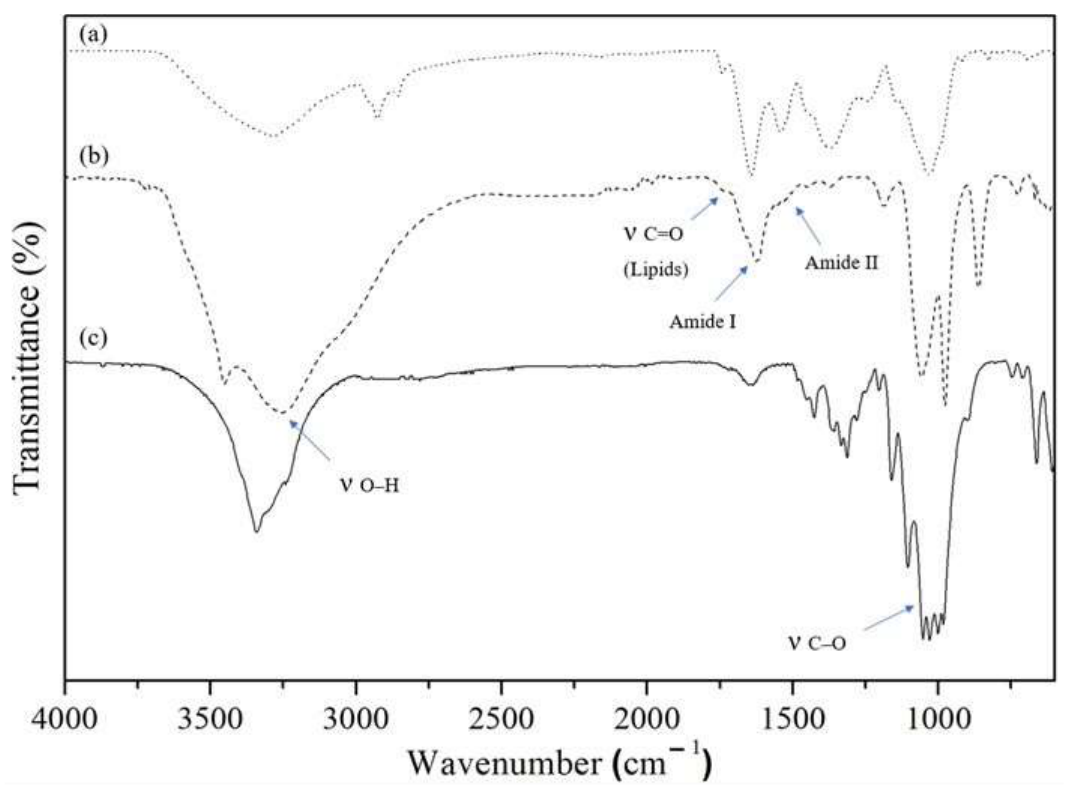
Figure 5. ATR-FTIR spectra of ( a ) microalgae C. debaryana , ( b ) biofilm produced by symbiotic growth of K. saccharivorans and C. debaryana and ( c ) regular BC produced by K. saccharivorans .